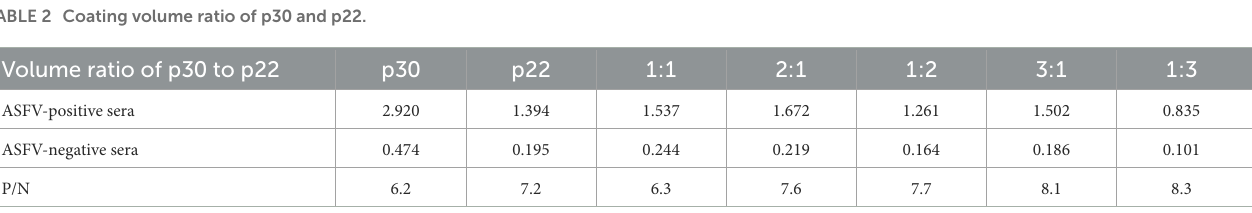
TABLE 2 Coating volume ratio of p30 and